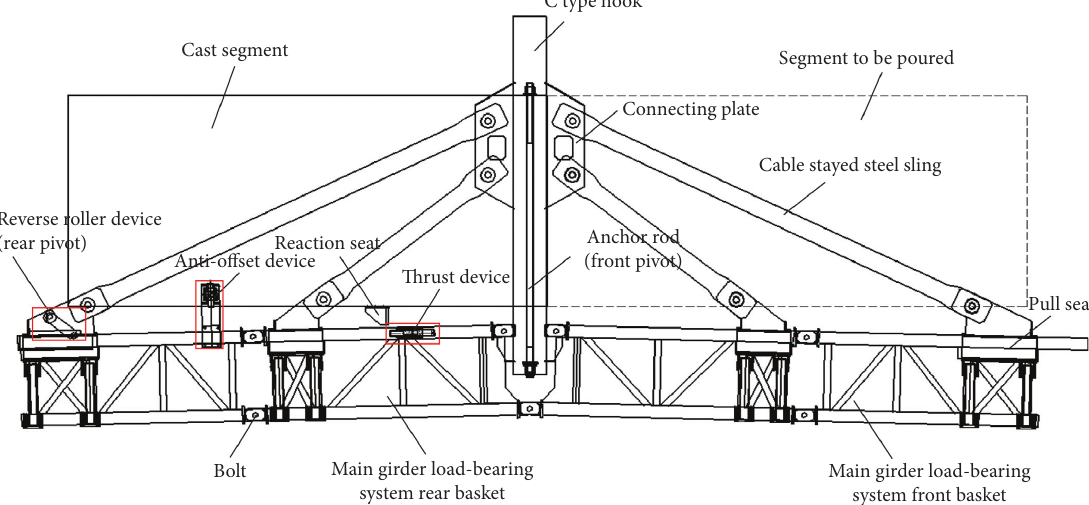
Figure 15: Front view of new triangular truss hanging basket.